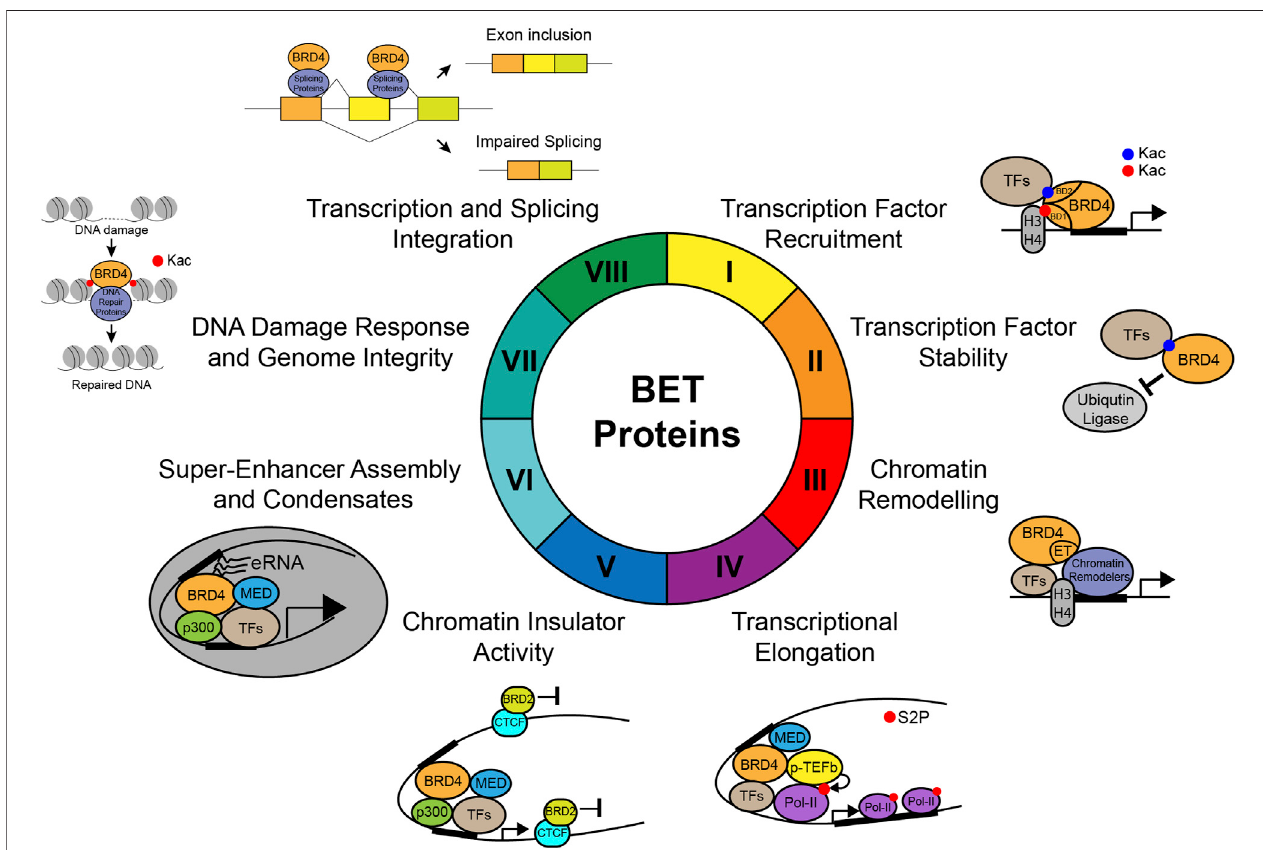
FIGURE 4 | Molecular functions of BET proteins in gene transcription in chromatin. Illustration of the molecular functions of BET proteins in regulation of gene transcription in chromatin, including (I) transcription factor recruitment, (II) transcription factor stability, (III) chromatin remodeling, (IV) transcriptional elongation through phosphorylation of RNA Pol-II Ser2, (V) chromatin insulator activity, (VI) super-enhancer assembly and condensates, (VII) DNA damage response and genome integrity, and (VIII) integration of gene transcription and splicing.